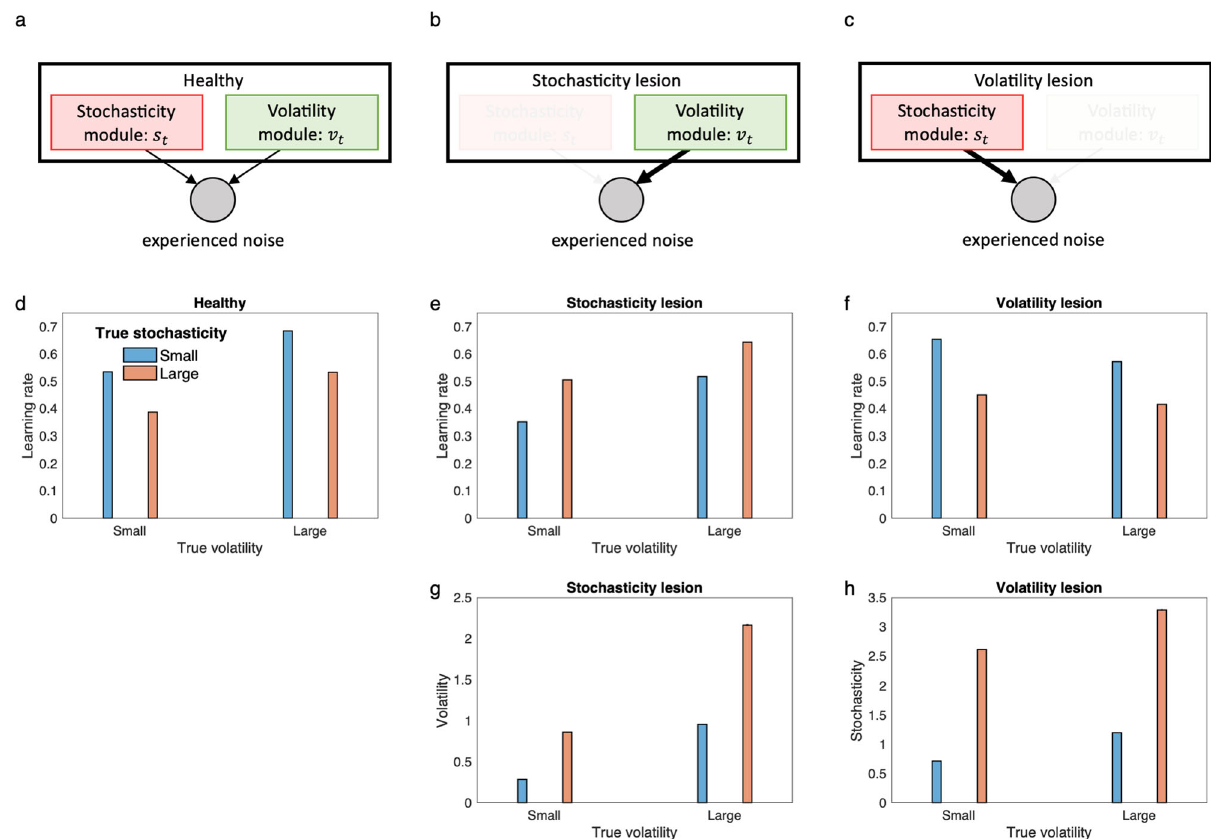
Fig. 3 Behavior of the lesioned model. a Stochasticity and volatility module inside the model compete to explain experienced noise. b – c Two characteristic lesioned models produce seemingly contradictory behaviors, because if the stochasticity module is lesioned, noise due to stochasticity is misattributed to volatility ( b ), and vice versa ( c ). d – f Mean learning rate is plotted for the 2 × 2 design of Fig. 2 for the healthy and lesioned models. For both the lesion models, lesioning does not merely abolish the corresponding effects on learning rate, but reverses them. Thus, the stochasticity lesion model shows elevated learning rate with increases in stochasticity ( e ), and the volatility lesion model shows reduced learning rate with increases in volatility ( f ). This is due to misattribution of the noise due to the lesioned factor to the existing module. g The stochasticity lesion model makes erroneous inference about volatility and increases its volatility estimate in higher stochastic environments. h The volatility lesion model makes erroneous inference about stochasticity and increases its stochasticity estimate for higher volatile environments. In fact, both the lesion models are not able to distinguish between the volatility and stochasticity and therefore show similar pattern for the remaining module. For the healthy model, volatility and stochasticity estimates are the same as Figs. 2b and 2c, respectively. Simulation and model parameters were the same as those used in Fig. 2. Errorbars re fl ect standard error of the mean computed over 10,000 simulations and are too small to be visible. Source data are provided as Source Data fi